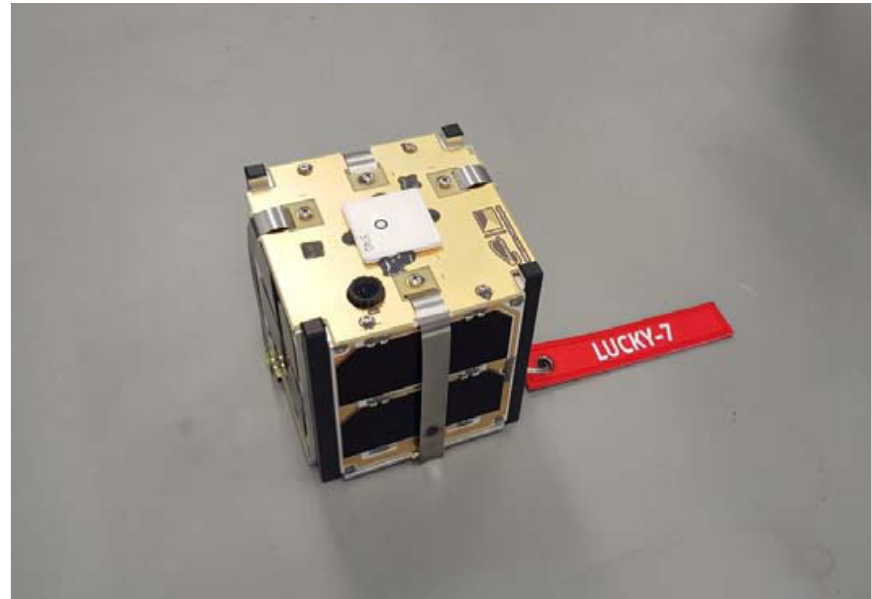
Figure 1. Lucky ‐ 7 CubeSat. Figure 1. Lucky-7